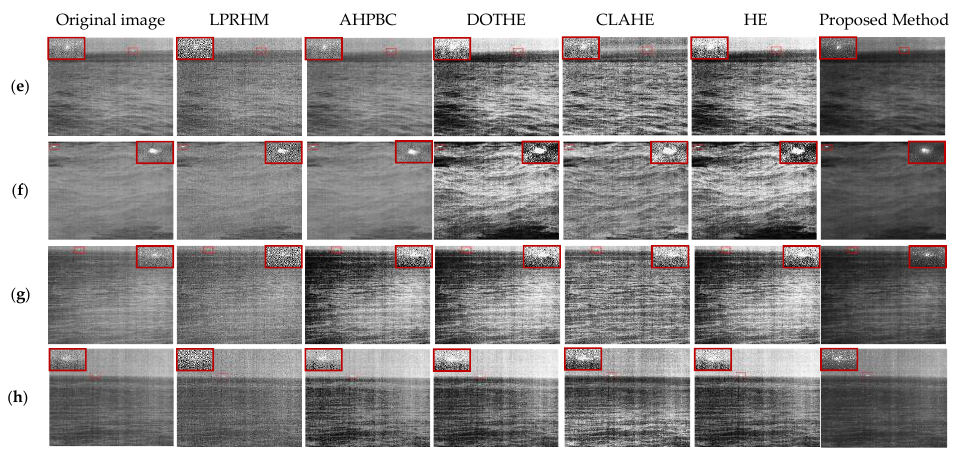
Figure 16. Comparison of image enhancement effects of rough sea images. ( e – h ) are the experimental results of the rough sea image in Figure 13e – h. The first column is the original image, the second to the sixth column are the results of the five comparison methods, and the seventh column is the proposed method.